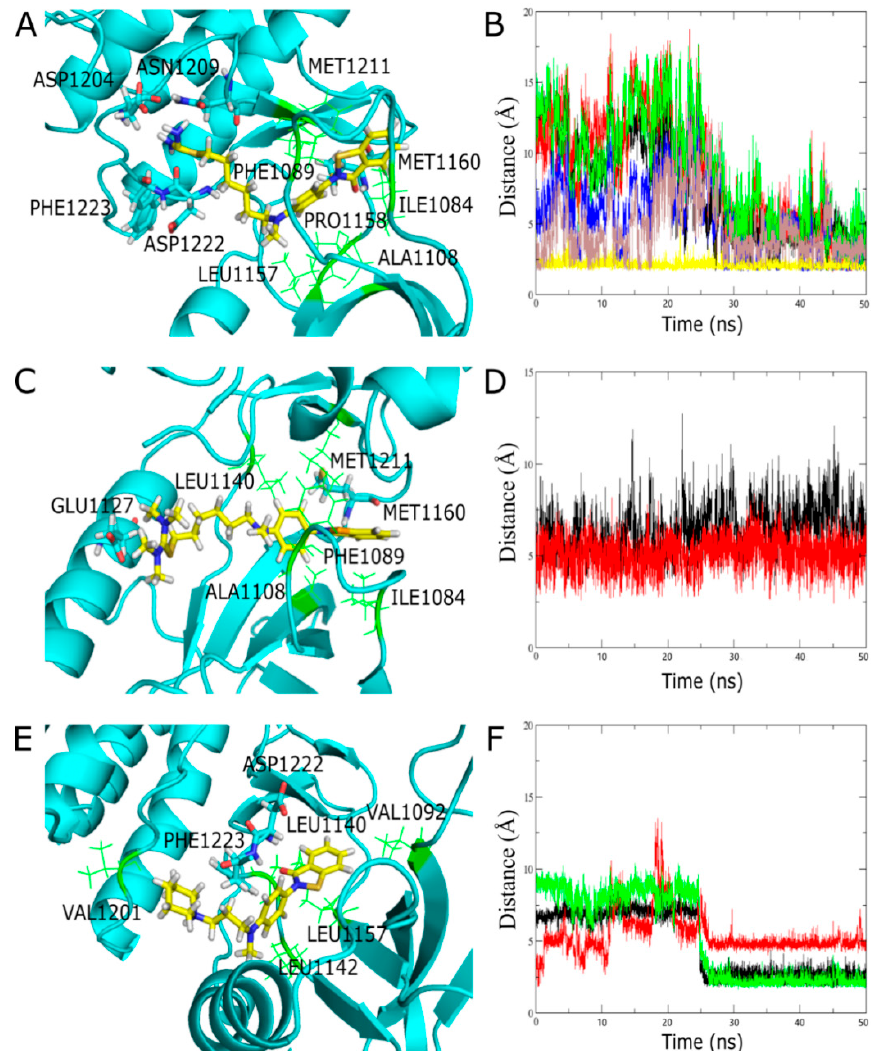
Figure 6. Analysis of the stability of compound / c-Met over 50 ns (from molecular dynamics simulations). ( A ) The binding mode of compound 7a (yellow) in the binding site of c-Met (cyan and green) and its binding pocket. ( B ) The hydrogen bond interactions of 7a –MET1160 (yellow), 7a –ASP1204 (red and green), 7a -ASN1209 (black), 7a -ASP1222 (blue) and 7a –PHE1223 (brown). ( C ) The binding mode of compound 8a (yellow) in the binding site of c-Met (cyan and green) and its binding pocket. ( D ) The hydrogen bond interactions of 8a –MET1211 (black) and the ionic bond of 8a –GLU1127 (red). ( E ) The binding mode of compound 12c (yellow) in the binding site of c-Met (cyan and green) and its binding pocket. ( F ) The hydrogen bond interactions of 12c –ASP1222 (black) and 12c –PHE1223 (red and green).